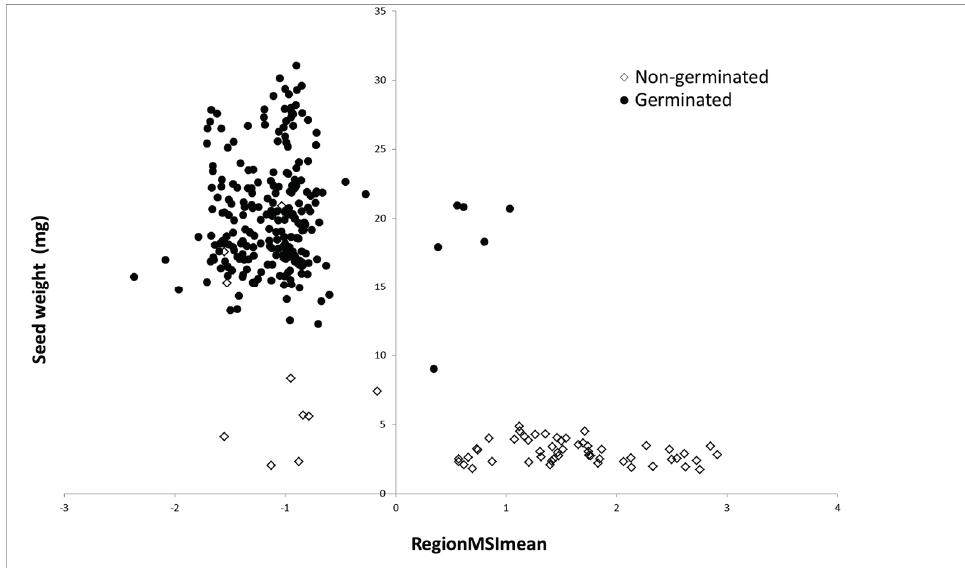
Figure 8. Plot of seed weight and RegionMSImean value (feature extracted from images) for germinated and non-germinated seeds. Seeds below zero are predicted as viable and seeds above are predicted ad dead